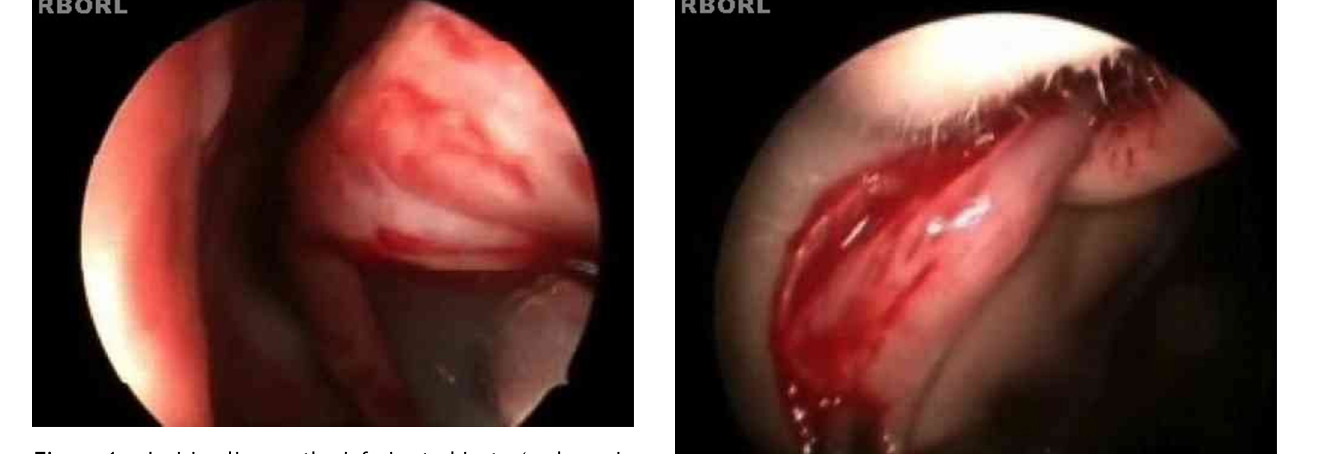
Figure 1 Incision line on the inferior turbinate (endoscopic view).